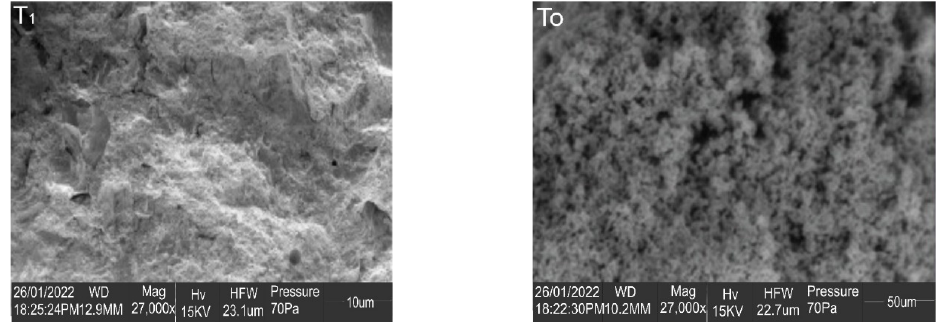
Figure 3. Molecular structure of the water before and after magnetization T 1 = Magnetically treated water; To = non-magnetically treated water (Magnification SEM =